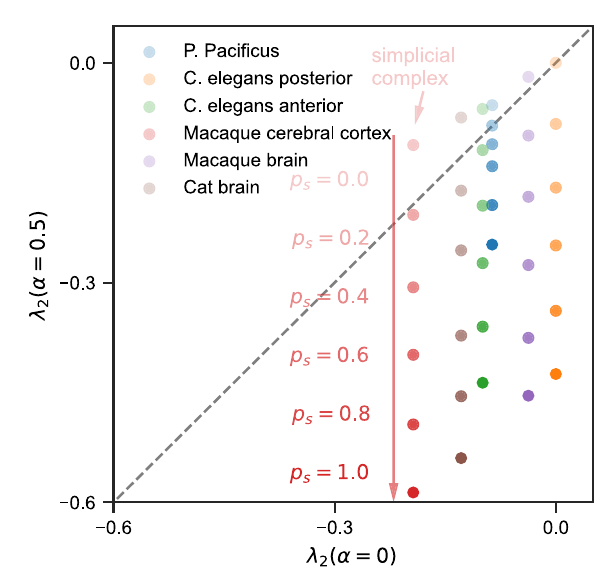
Fig. 6 | Nonpairwise interactions typically enhance synchronization in hyper- graphs,exceptwhentheyareclosetobeingasimplicialcomplex. Thisplotuses the same data as in Fig. 5 and explicitly shows the transition in how higher-order interactions affectsynchronization asthe hypergraph structure loses resemblance to simplicial complexes. Points in the upper-left half of the square represent hypergraphs for which higher-order interactions impede synchronization, while pointsinthelower-righthalfofthesquarerepresenthypergraphsforwhichhigher- order interactions promote synchronization. As the shuf fl ing probability p s is increased( p s =0correspondstosimplicialcomplexes),allsixsystemsswiftlymove across the diagonal line and into the synchronization-promoting